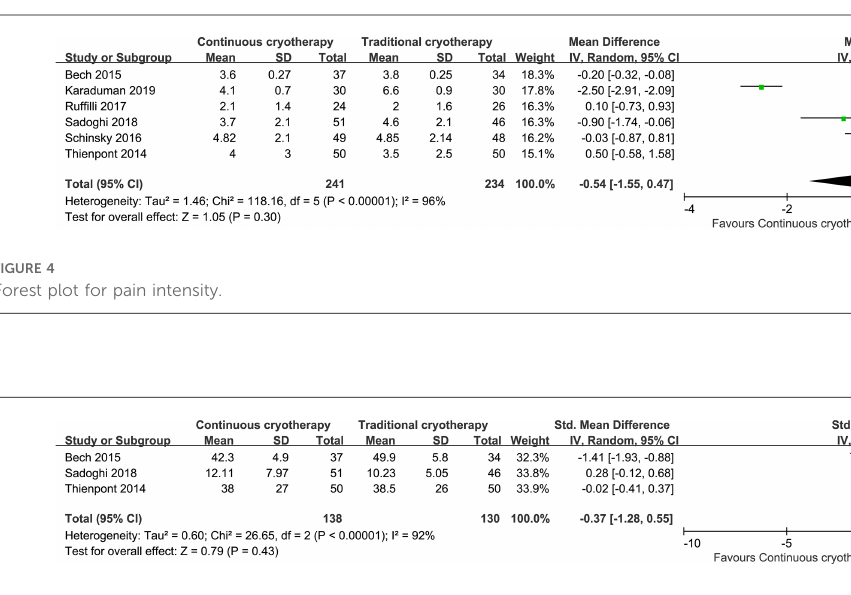
FIGURE 5 Forest plot for analgesics consumption.